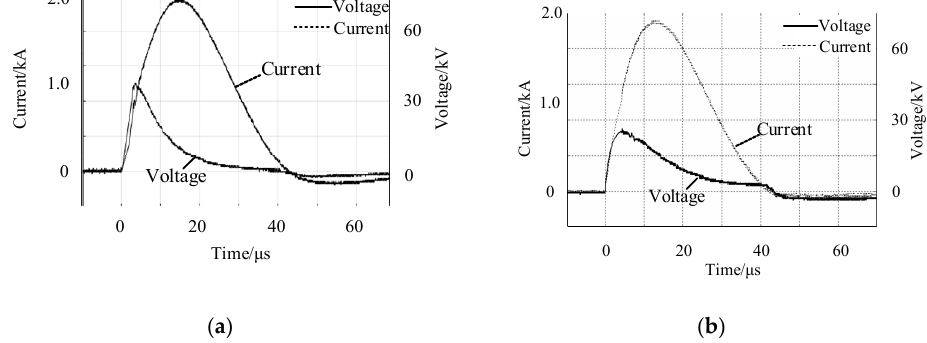
Figure 6. Current and voltage waveform of soil of different soil resistivity when injected into impulse current: ( a ) ρ = 300 Ω ·m; ( b ) 700 Ω ·m.